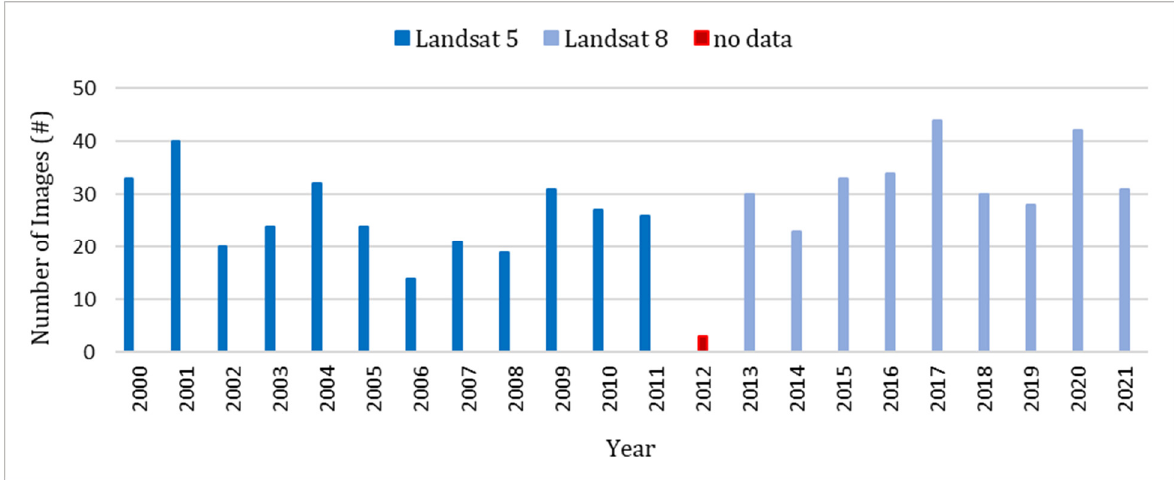
Figure 2. The number of the used satellite imageries across the years.